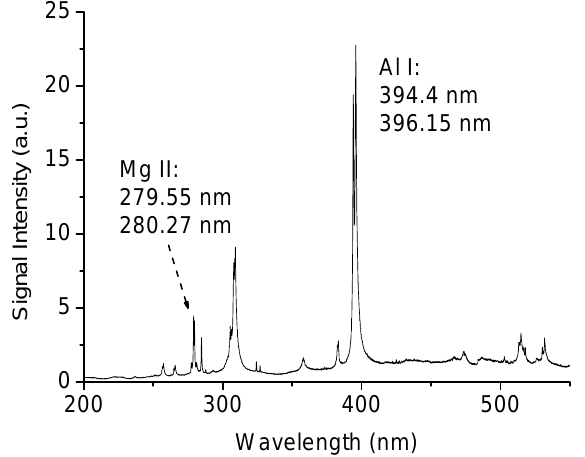
Figure 6. R-FIBS spectrum taken for aluminum sample located 50 m away. The gate width of the ICCD detector was set to 20 µs and the gate was opened 33 ns before the laser pulse arrived at the